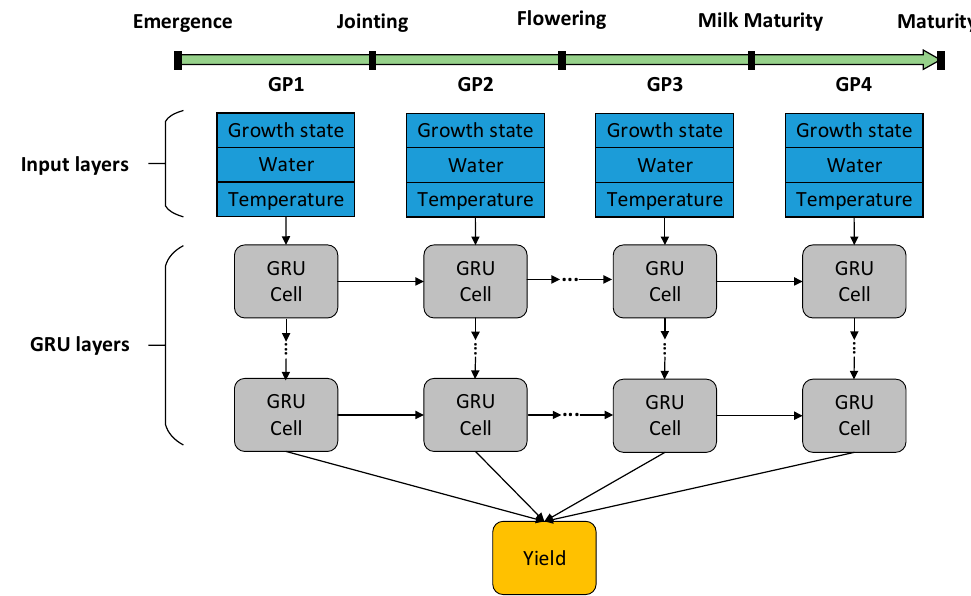
Figure 3. The architecture of the GRU yield prediction model. GRU represents The Gated Recurrent Unit model. GP represents growth phase. GP1: from emergence to jointing, GP2: from jointing to flowering, GP3: from flowering to milk maturity, GP4: from milk maturity to maturity.